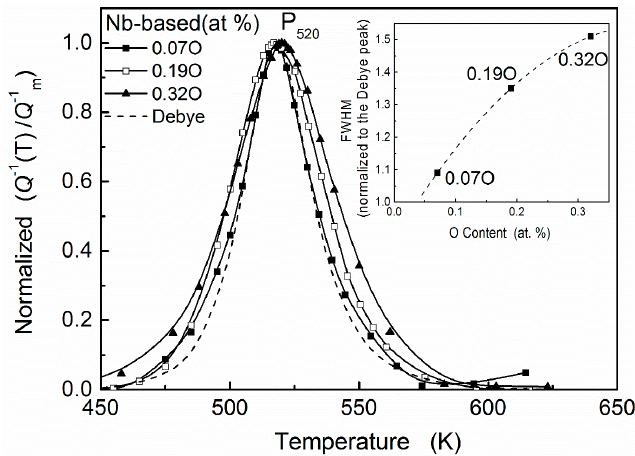
Figure 1. Normalized relaxation peaks for Nb–0.5V alloys with 0.07, 0.18, and 0.32 at. % O. Comparison with a theoretical Debye peak at 520 K with an activation energy determined by Marx–Wert equation.